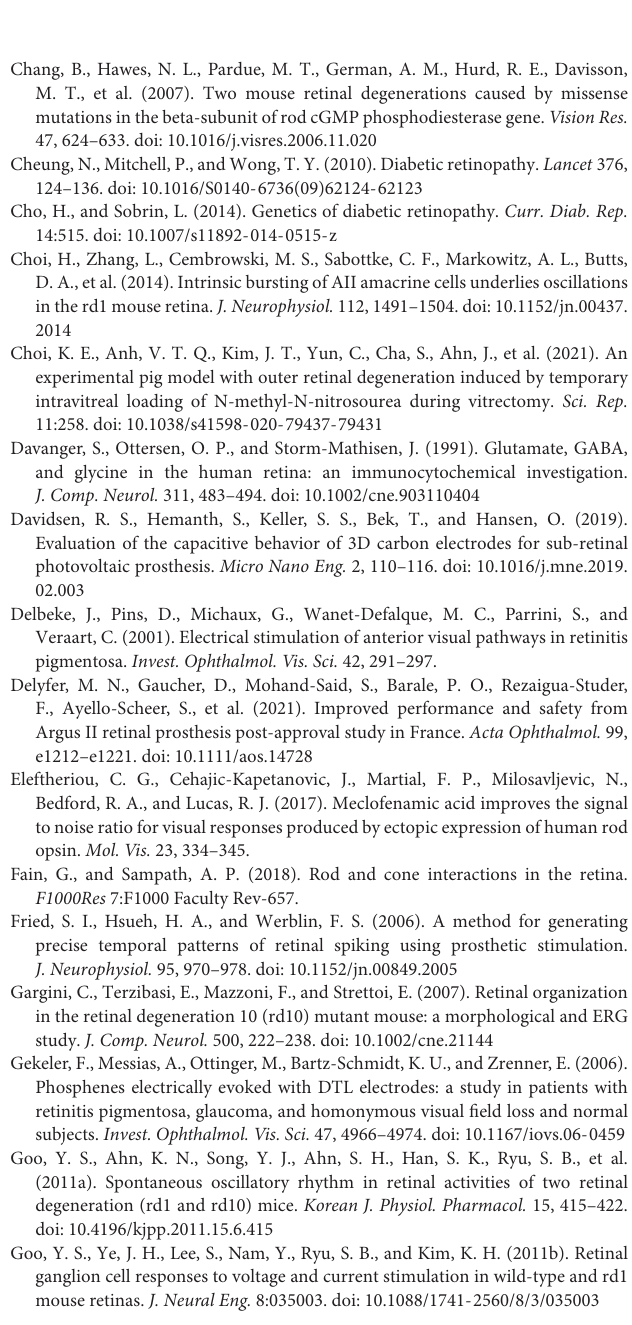
Supplementary Figure 1 | Generation of Pde6b knockin mouse using CRISPR-Cas9. (A) A schematic illustration showing the location of the Pde6b target gRNA, HhaI restriction sites, and primer binding sites along with C to T mutation point. (B) Initial screening of F0 Pde6b knockin mutants with PCR genotyping. Digestion of PCR products with HhaI yielded 3, 4, and 2 DNA